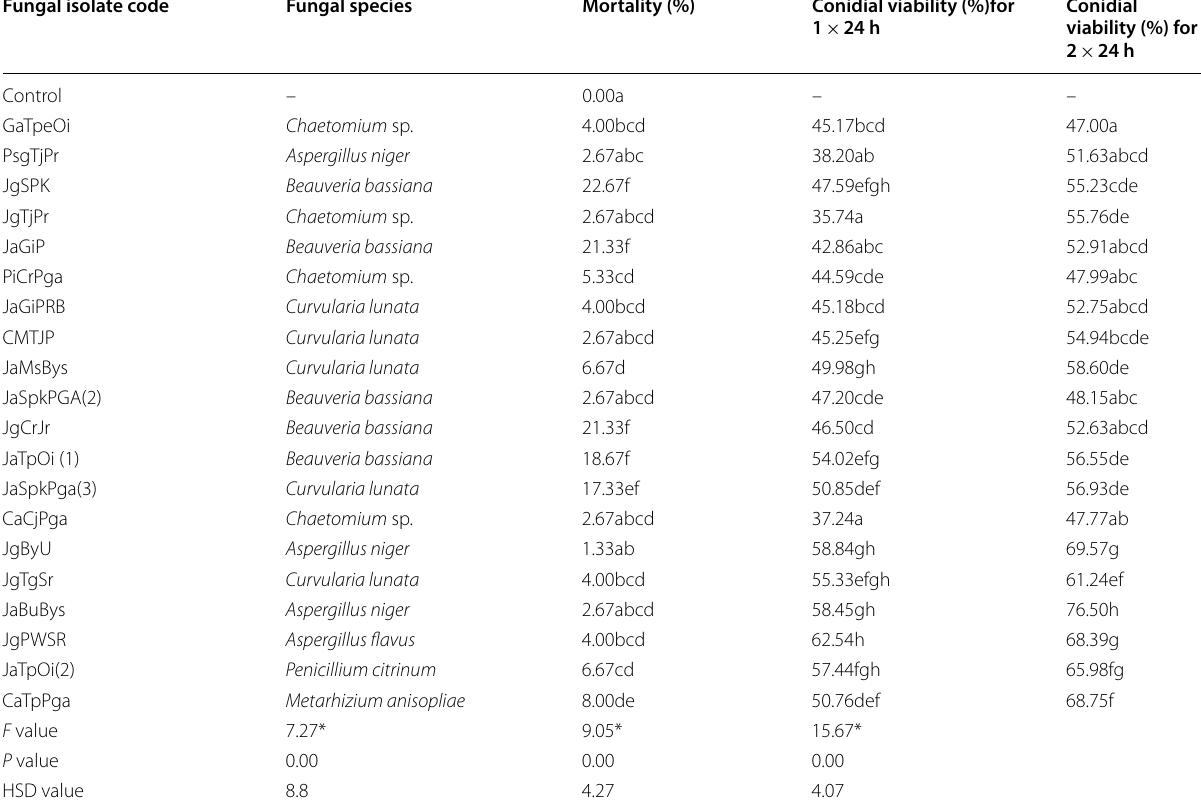
* significantly different; values within a column followed by the same letters were not significantly different at P < 0.05 according to Tukey’s HSD =